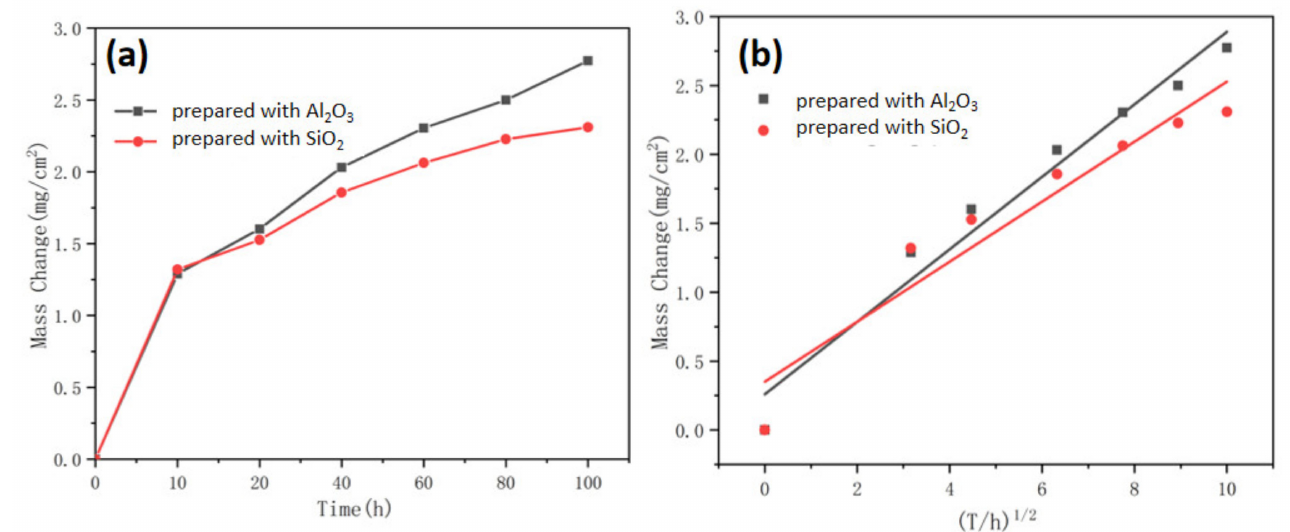
Figure 4. ( a ) Oxidation curve of B modified silicides coatings prepared with Al 2 O 3 and SiO 2 inert-filler at 1250 ◦ C for 100 h; ( b ) representation of the weight gain versus the square root of time for the B modified